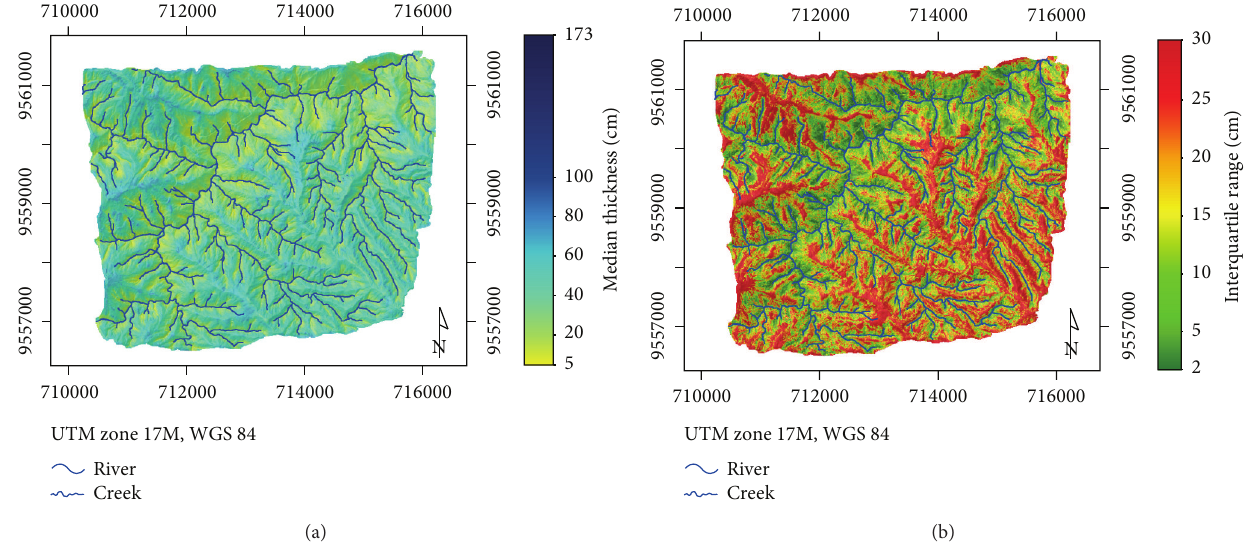
Figure 7: Median thickness of stagnic soil horizon (a) and interquartile range (b) (overlaid hillshading from north).